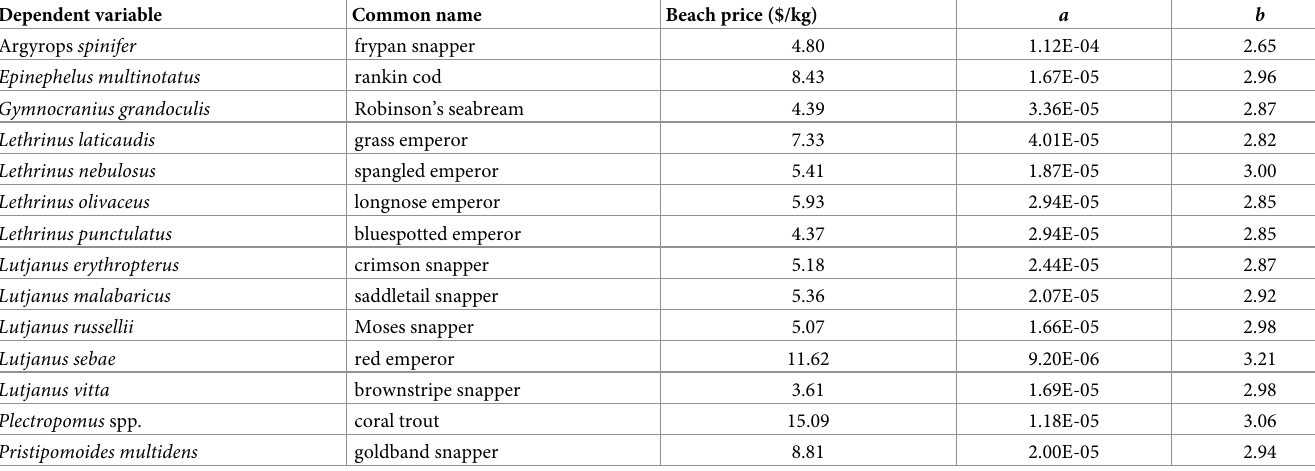
Table 1. Commercial fishery species most prevalent in trap, trawl and line fisheries operating in the Pilbara region of the North Coast Bioregion.